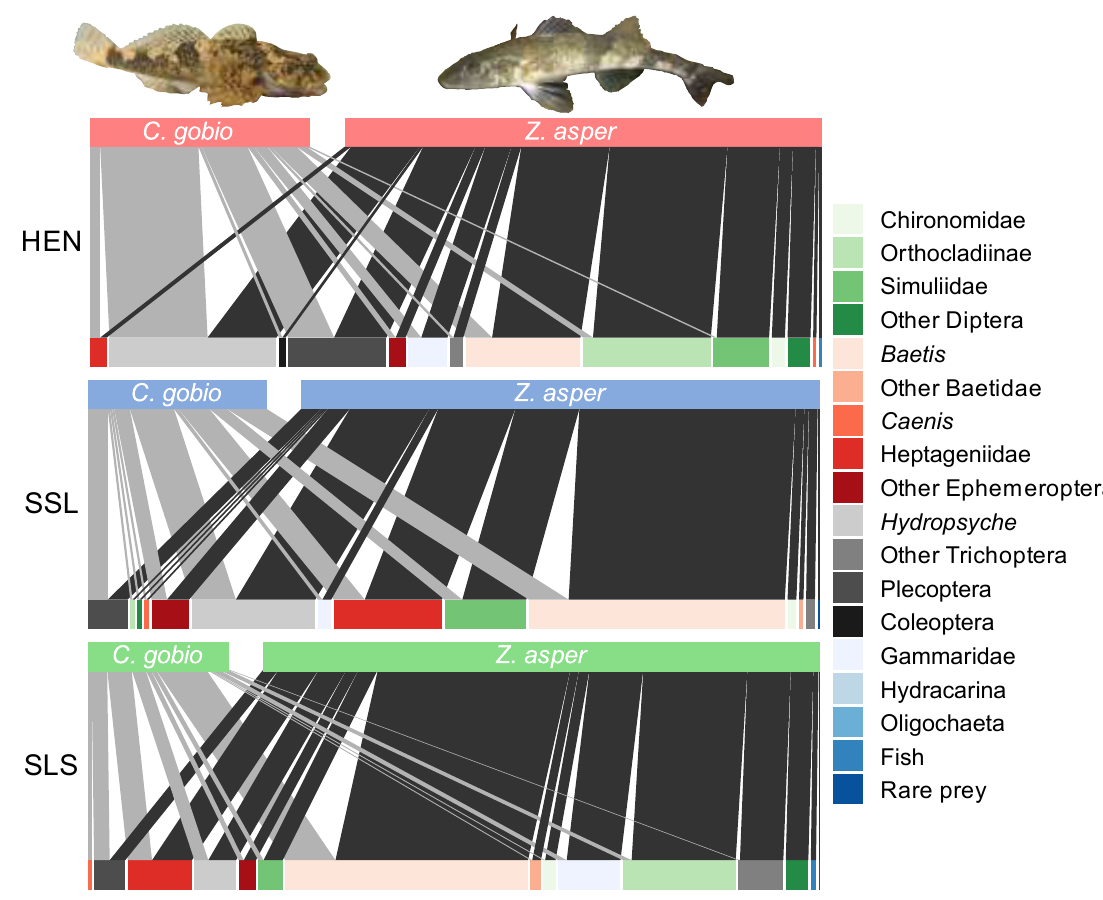
Figure 6. Bipartite plots illustrating dietary overlap between C. gobio and Z. asper at HEN, SSL and SLS.